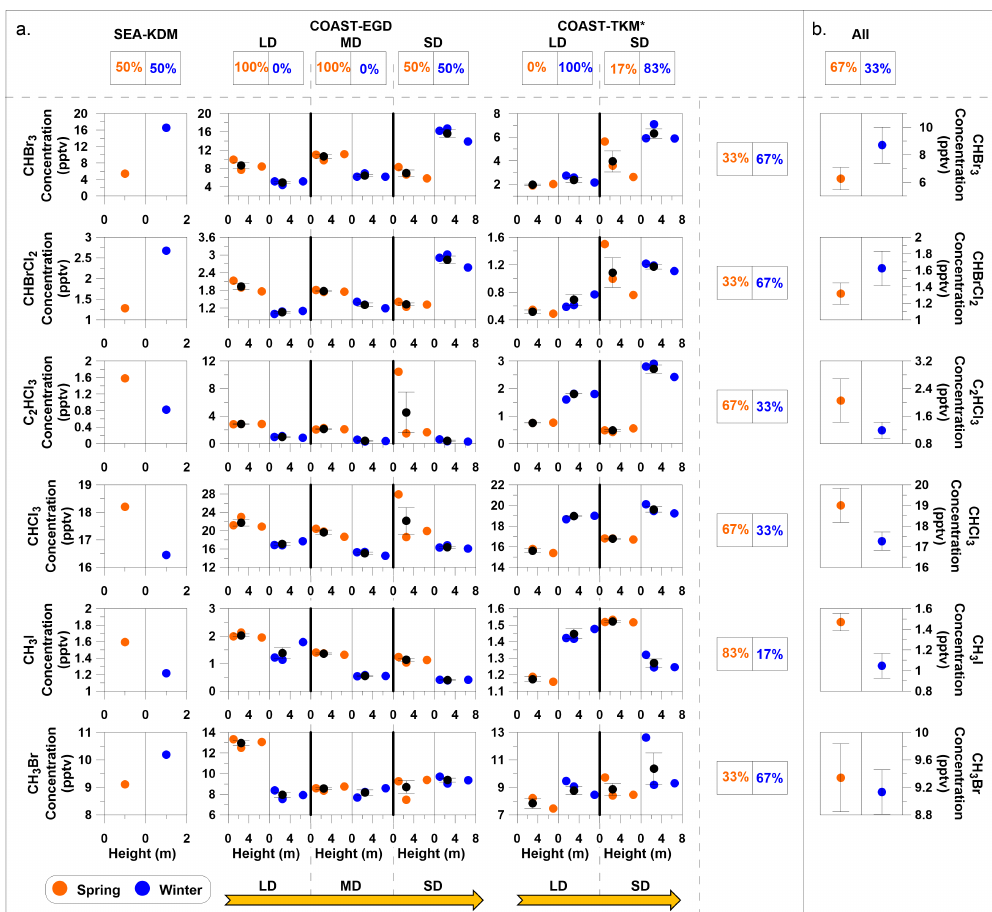
Figure 5. Seasonal and spatial influences on measured mixing ratios of VHOCs for coastal sites only. (a) Measured VHOC mixing ratios are presented vs. vertical height above surface level, separately for winter (blue) and spring (orange). Black filled circles and error bars represent average and standard error of the mean (SEM), respectively. LD, MD and SD indicate long, medium and short distance from the seawater, respectively, while SEA–KDM is located at the seawater (see Sect. 2.1.1). Values above and to the right of the figure indicate the percentages of higher average mixing ratios in spring (left box) or winter (right box) individually, for each site (SEA–KDM, COAST–TKM and EGD sites) and for each specific species. (b) For each species, the average mixing ratios over all sites (SEA–KDM, COAST–EGD and COAST–TKM) are presented (All), and the corresponding percentage of higher average mixing ratios in spring and in winter are also presented. See Table 1 for measurement site abbreviations. Species with no observed difference between seasons were excluded (see Fig. S1 in the Supplement for complete information); y axes for sites in the same coastal area (COAST–TKM or COAST–EGD) are evenly scaled. ∗ Measurements exclude one sampling canister at COAST–TKM-LD (see Sect.